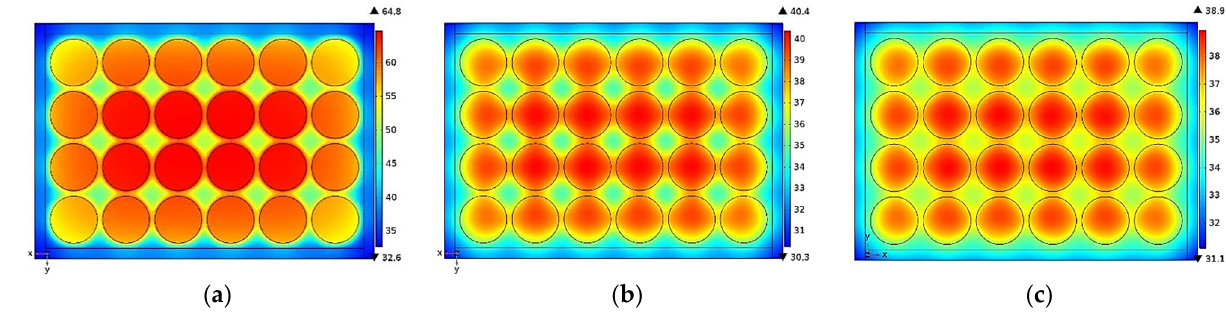
Figure 8. Temperature contour of the module using ( a ) natural convection (NC), ( b ) PCM, and ( c ) PCM-graphite (PCM-g) cooling methods under a 1.5C discharging rate.